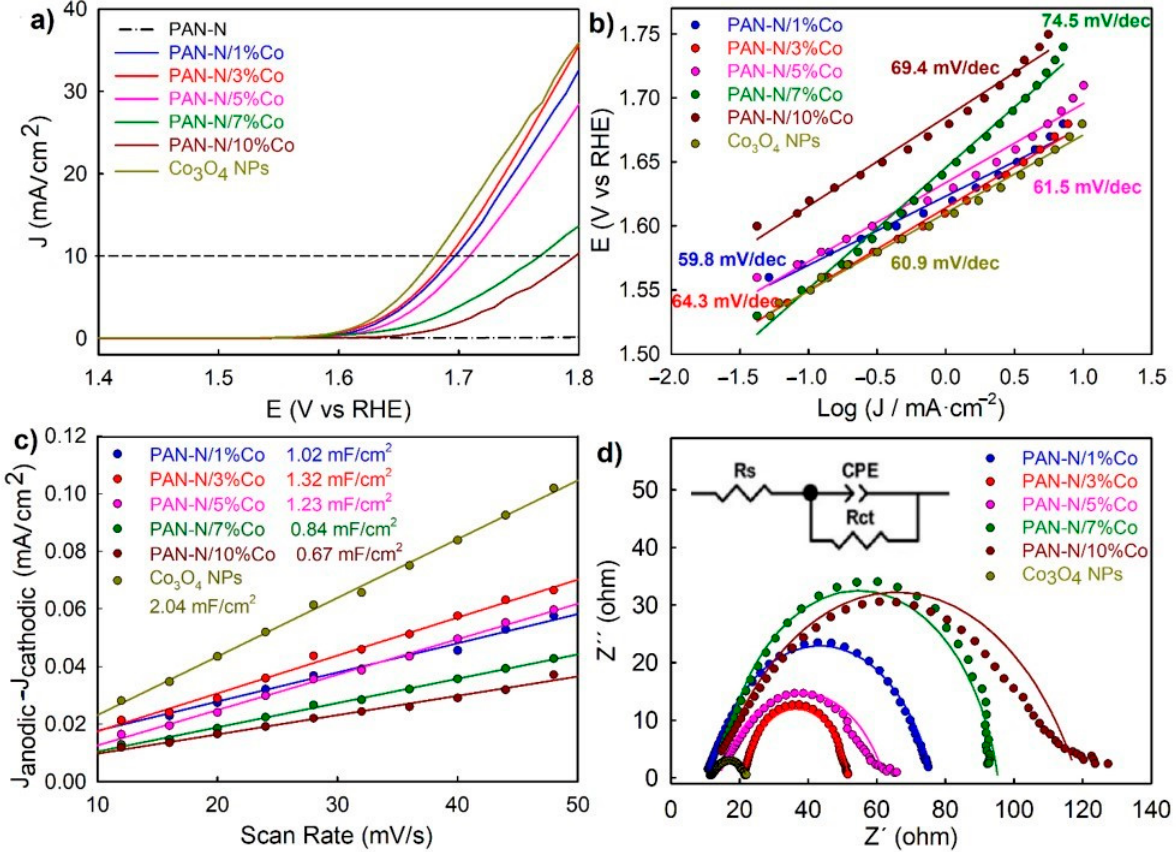
Figure 5. ( a ) Oxygen evolution reactions (OER) polarization curves obtained for the different PAN-N/Co samples, including the reference (Co 3 O 2 NPs), in 0.5 M KOH solution at 2 mV/s; ( b ) Tafel plots of the samples. The values are the slope of each curve: ( c ) Plots of difference of anodic and cathodic current density as a function of scan rate and ( d ) electrochemical impedance spectroscopy (EIS) obtained for the samples at the overpotential of 700 mV, with frequency from 100 kHz to 1 Hz and amplitude of 5 mV. Dots and lines represent the experimental and simulated data, respectively.